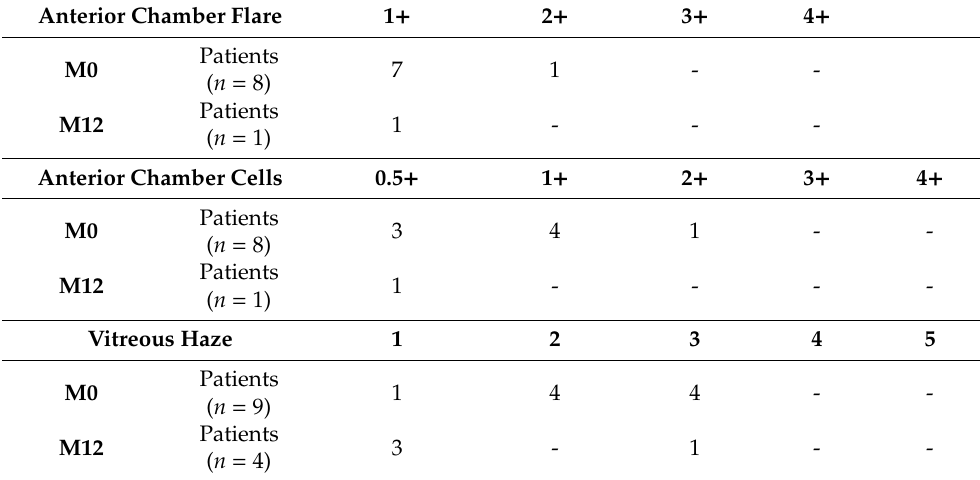
Table 2. Patient evaluation according to SUN Criteria.